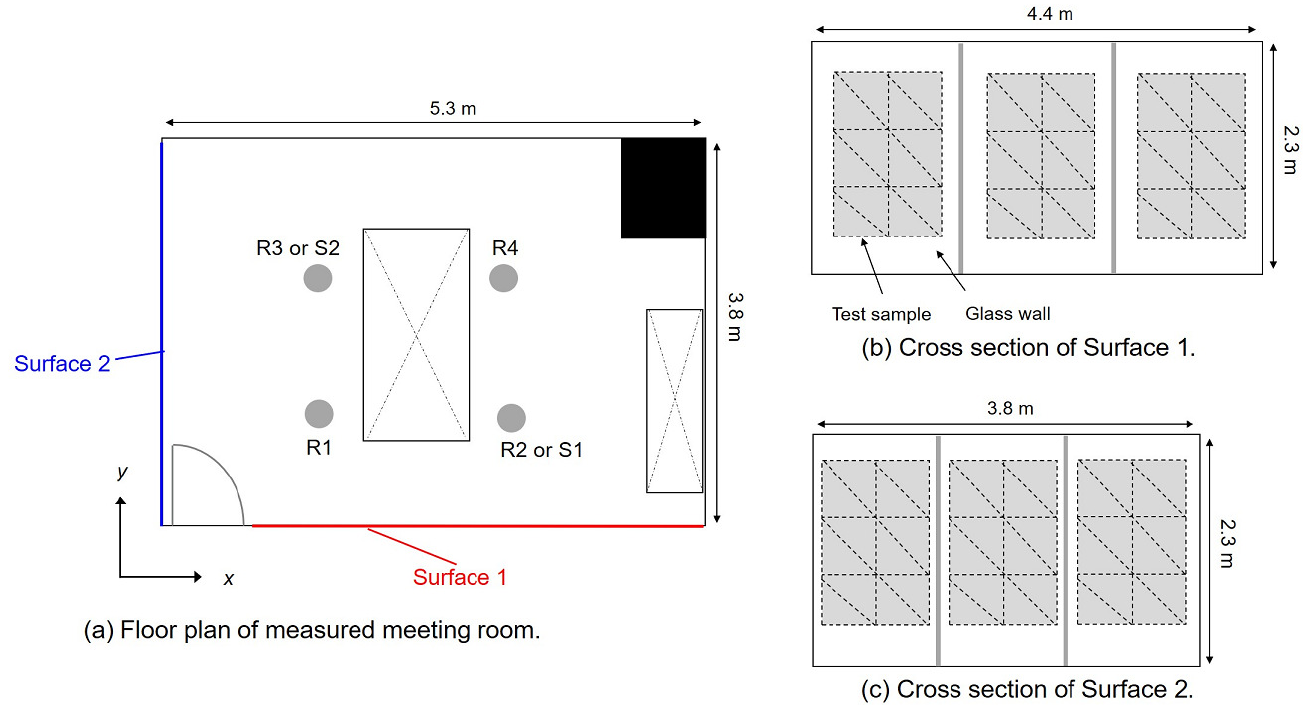
Figure 8. ( a ) Floor plan of the meeting room, including locations of source points and receiver points. ( b ) A cross-section of Surface 1, and ( c ) a cross-section of Surface